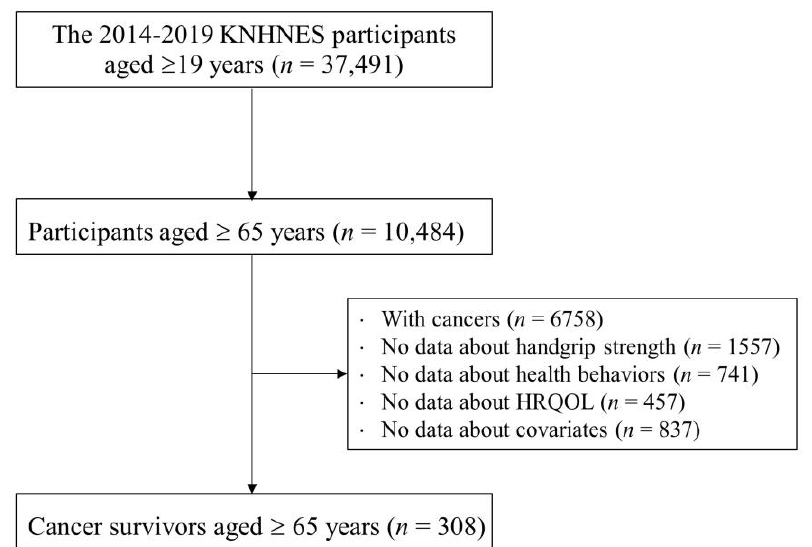
Figure 1. Flowchart for selection of study participants. KNHNES: Korean National Health and Nutritional Examination Survey; HRQOL: health-related quality of life.